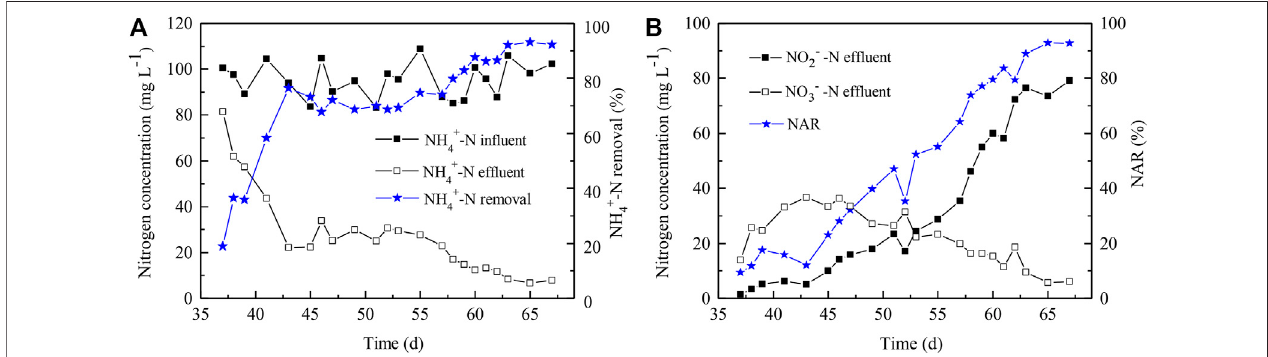
FIGURE 4 | Nitrogen removal performance in the microalgae-intensi fi ed PN reactor. (A) NH 4+ -N removal; (B) NO 2 − -N accumulation. NAR indicates nitrite accumulation rate and was calculated as Con. NO 2 − -N/(Con. NO 2 − -N + Con. NO 3 − -N) × 100